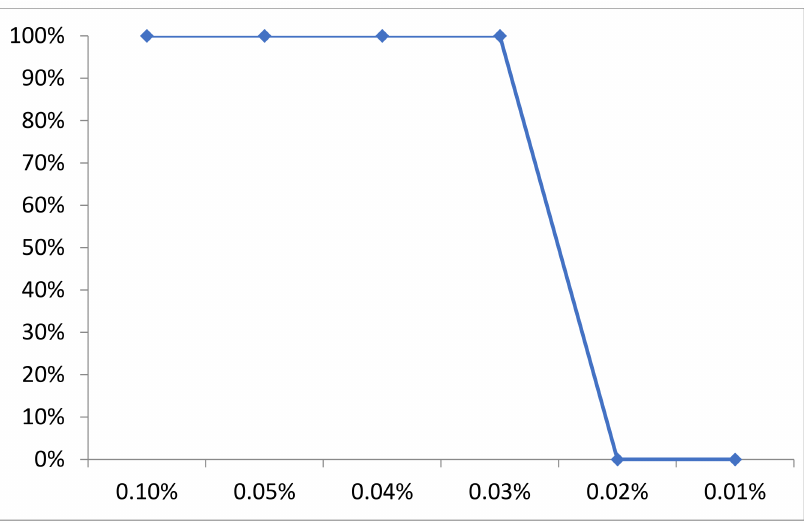
Figure 6. Carvacrol oil antibacterial effect on MDR Staphylococcus